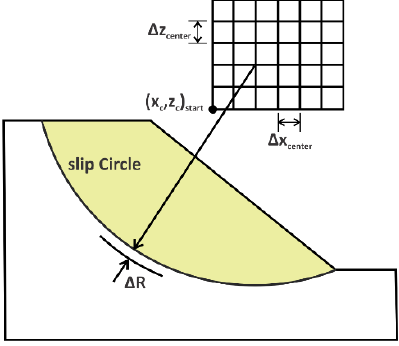
Figure 10. Centers and radii for slip circles in slope stability analysis.